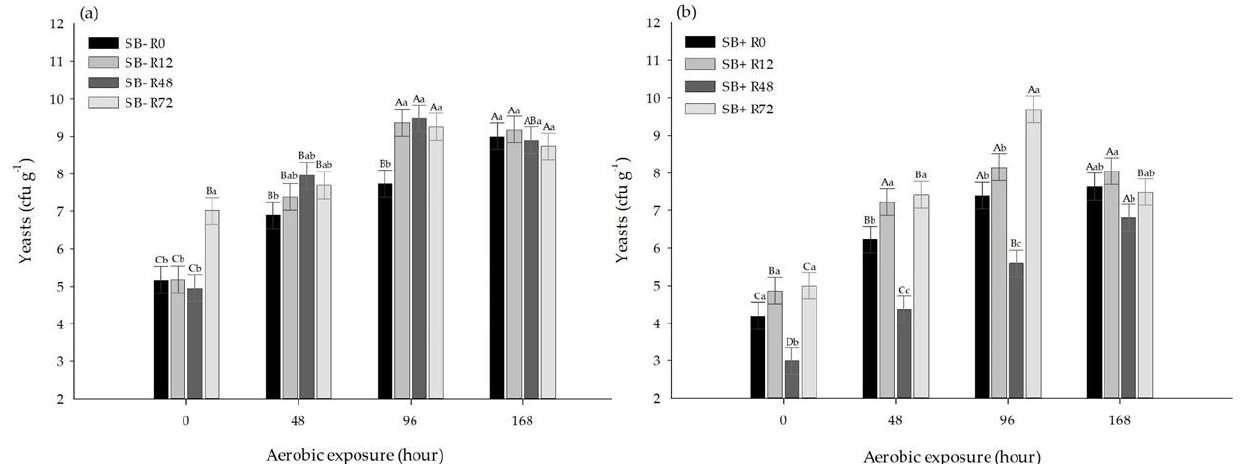
Figure 4. ( a ) The effects of the additive application (SB), relocation time, and aerobic exposure time interaction (SB × R × AE) on the yeast count in sugarcane silage that was stored for 10 days: SB − , without additive; ( b ) the effects of the additive application (SB), relocation time, and aerobic exposure time interaction (SB × R × AE) on the yeast count in sugarcane silage that was stored for 10 days: SB+, with sodium benzoate (at 2 g · kg − 1 on a fresh matter basis). Means followed by lowercase letters differ from each other within each aerobic exposure time according to Tukey’s test ( p > 0.05). Means followed by uppercase letters differ between aerobic exposure times according to Tukey’s test ( p > 0.05).